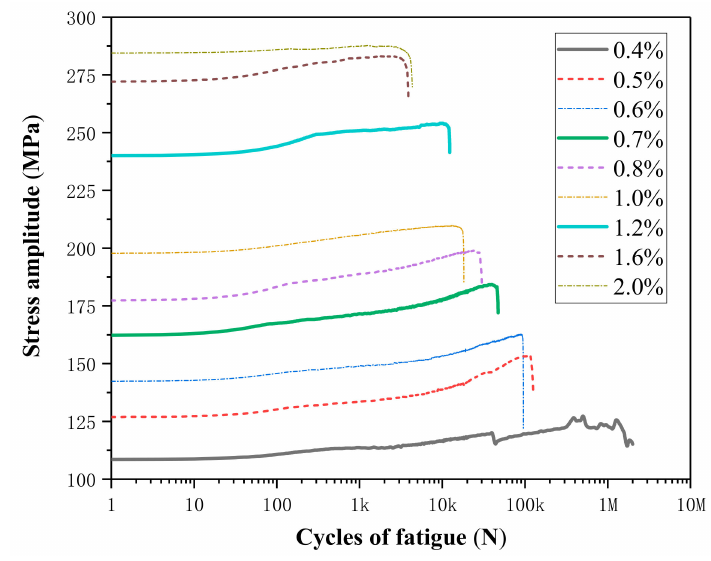
Figure 6. Stress amplitude curves of di ff erent strain amplitudes at 40 ◦ C.